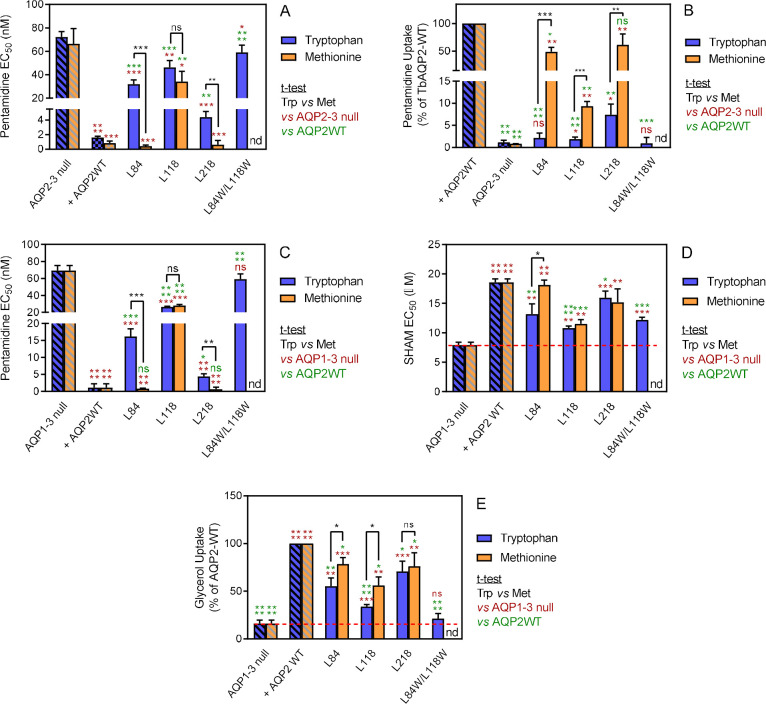
Analysis of TbAQP2 variants with a leucine-to-tryptophan or leucine-to-methionine substitution near the cytoplasmic end of the pore.(A) Pentamidine EC50 values (nM) for mutant and WT TbAQP2 expressed in tbaqp2/tbaqp3 cells (aqp2-3 null). The mutants are either a Trp (dark blue bars) or Met (orange bars) substitution at the indicated positions. The resistant control (aqp2-3 null) and sensitive control (AQP2WT) for the separate datasets (Trp or Met) are indicated as hatched bars in the same colours. (B) As (A) but showing transport of 30 nM [3H]-pentamidine by the same cell lines, expressed as percentage of the transport rate in the TbAQP2 control cells. (C) Pentamidine EC50 values for the same mutants as in (A) but expressed in the tbaqp1-2-3 null cells, performed in parallel with the determination of EC50 values for SHAM, shown in (D). As all cell lines were done simultaneously, the resistant and sensitive strain control values are identical for the Trp and Met mutants in this series. All bars represent the average and SEM of at least three independent replicates. *, p<0.05; **, p<0.01; ***, p<0.001, ****, p<0.0001 by unpaired Student’s t-test; ns, not significant; nd, not determined. All data for these graphs are contained in Figure 4—source data 1.Figure 4—source data 1.Individual and average EC50 values and transport rates for Figure 4A-E and Figure 4—figure supplement 1.